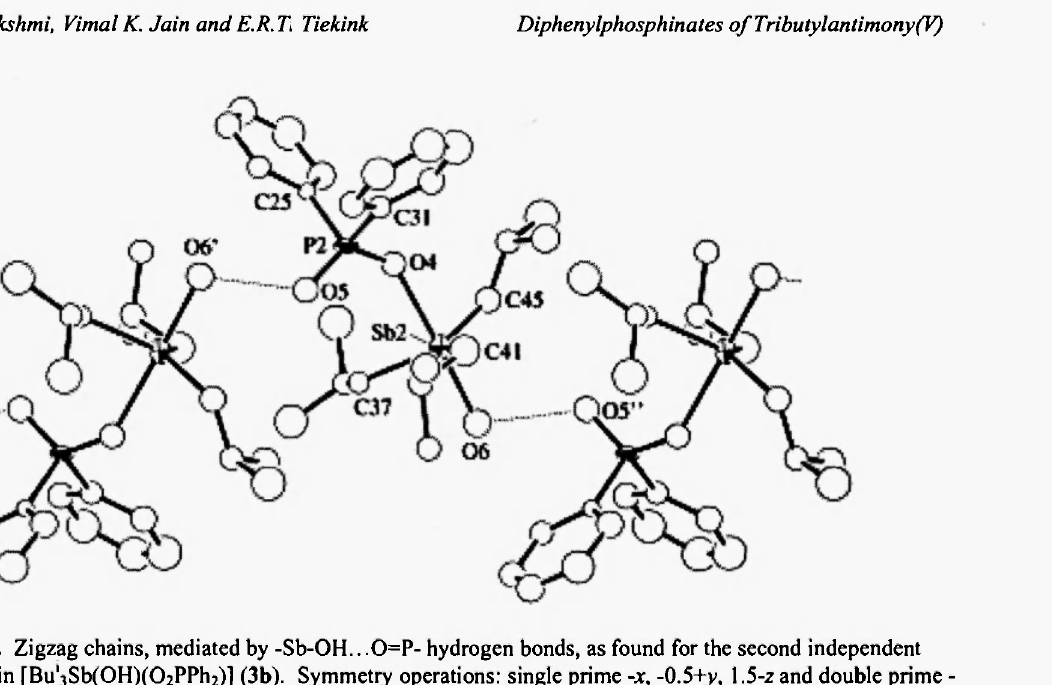
Fig. 2. Zigzag chains, mediated by -Sb-OH.. .0=P- hydrogen bonds, as found for the second independent molecule in [Bu'3Sb(0H)(0 2 PPh 2 )] (3b). Symmetry operations: single prime -x, -0.5+y, 1.5-2 and double prime - x, 0.5+y,